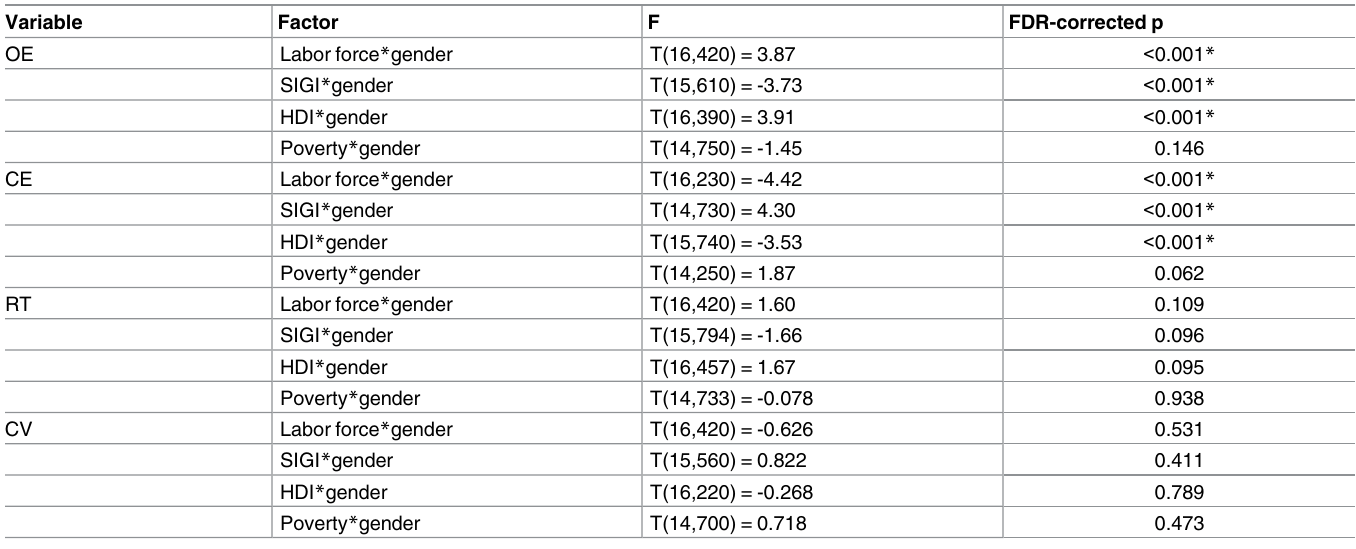
Table 4. Gender * sociocultural interactions in gradCPT